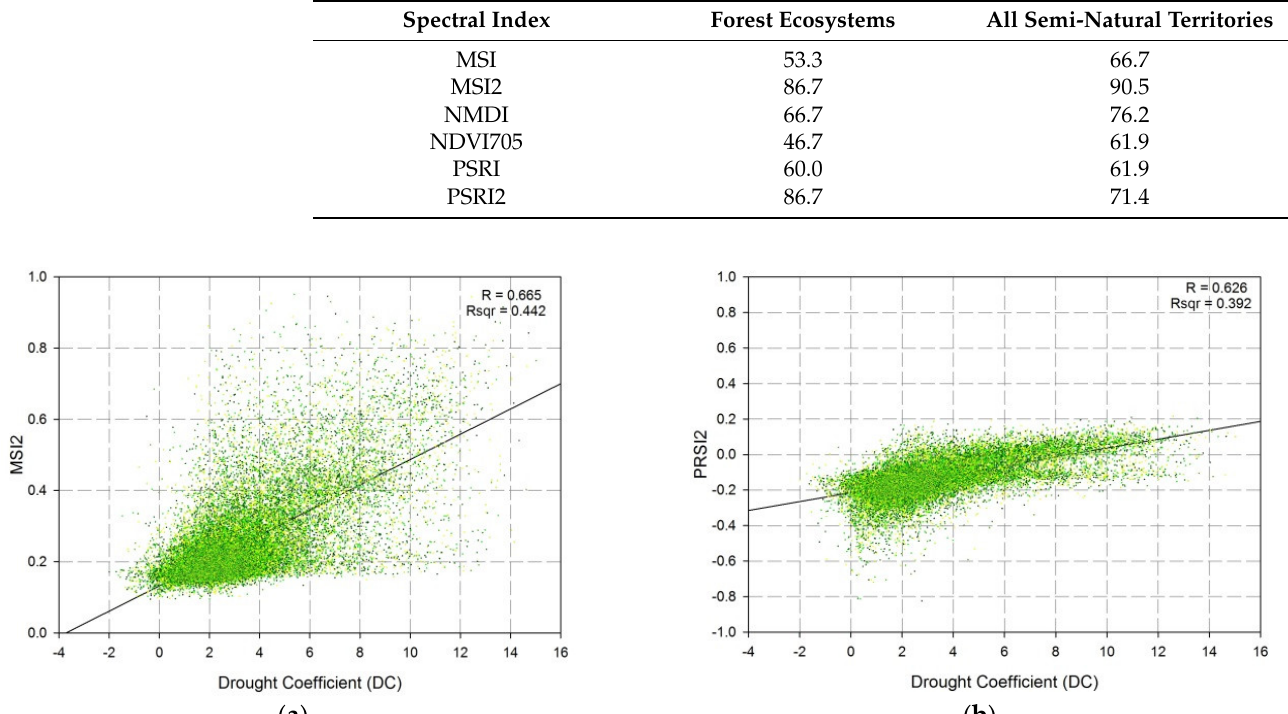
Table 7. Correlation coefficients (in %) between the individual Drought coefficient (DC) classes in the studied semi-natural territories and the spectral indices used in the validation process.